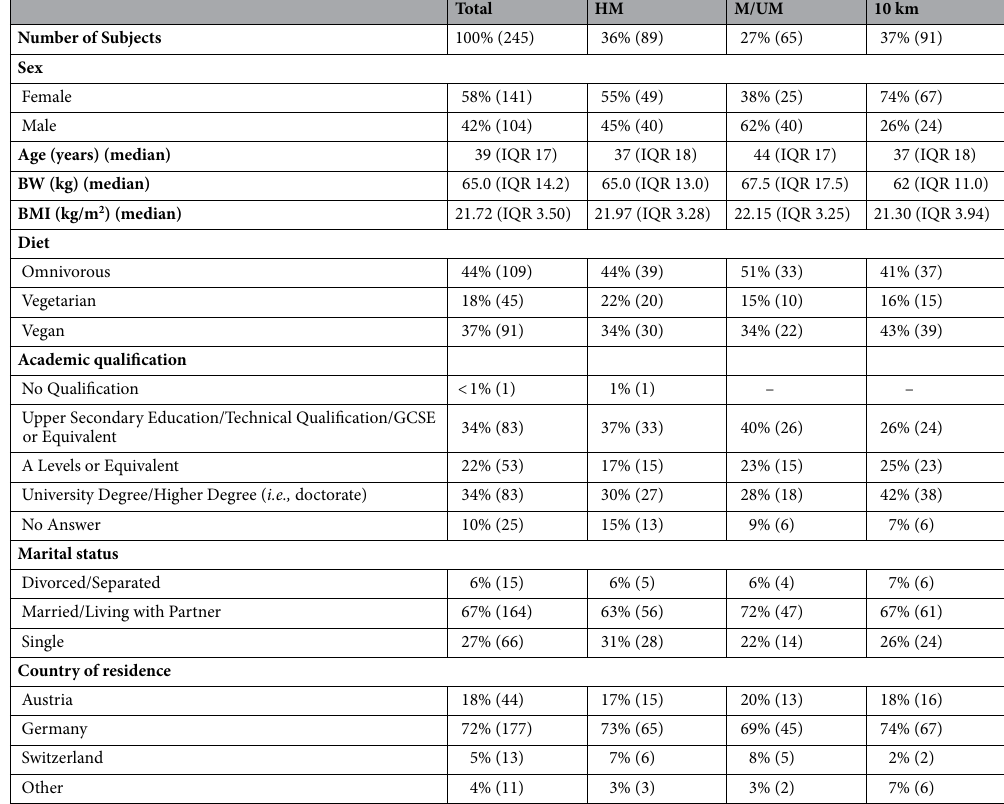
Table 1. Anthropometric and sociodemographic characteristics of the endurance runners. Data are presented as “percentage of prevalence (n)” or “median (IQR)”. BMI body mass index, BW body weight, HM